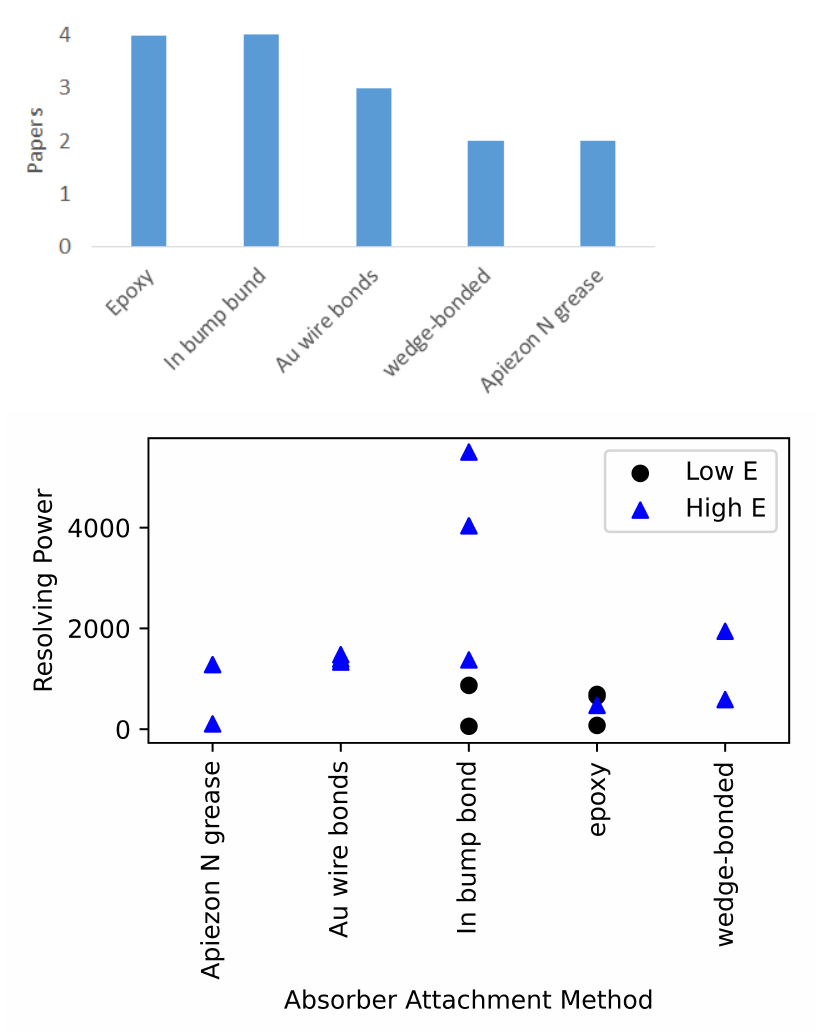
Figure 6. ( Top ) Absorber attachment methods used in Decay Energy Spectroscopy. ( Bottom ) The re- solving power can be seen as a function of absorber attachment method for both high energy DES and low energy DES